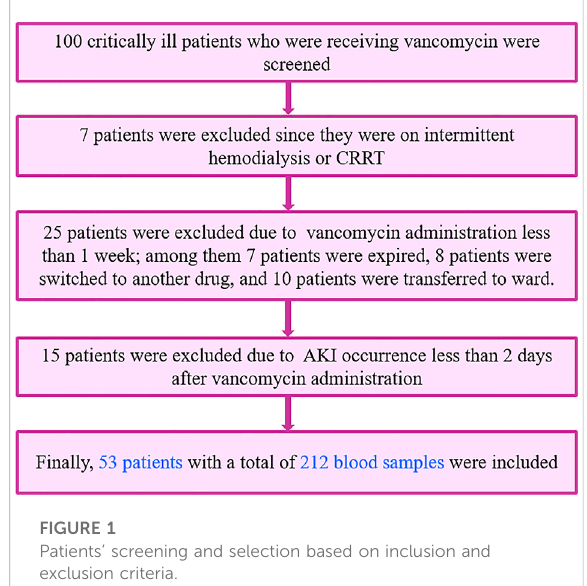
FIGURE 1 Patients ’ screening and selection based on inclusion and exclusion